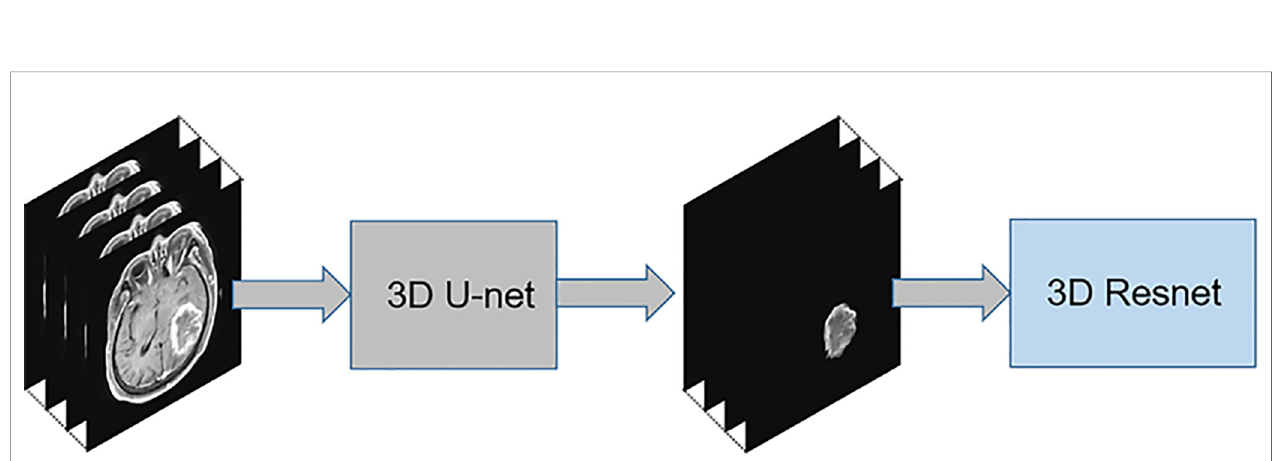
FIGURE 3 | The implementation process of the lesion area diagnosis